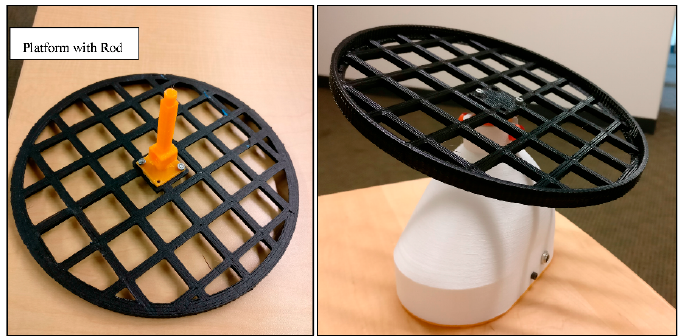
Figure 6. Platform printed with black PLA. The underside of the platform showing the attachment of the rod with M3 nuts and bolts is shown on the left and the platform mounted on the mixer assembly without the dimpled mat is shown on the right.